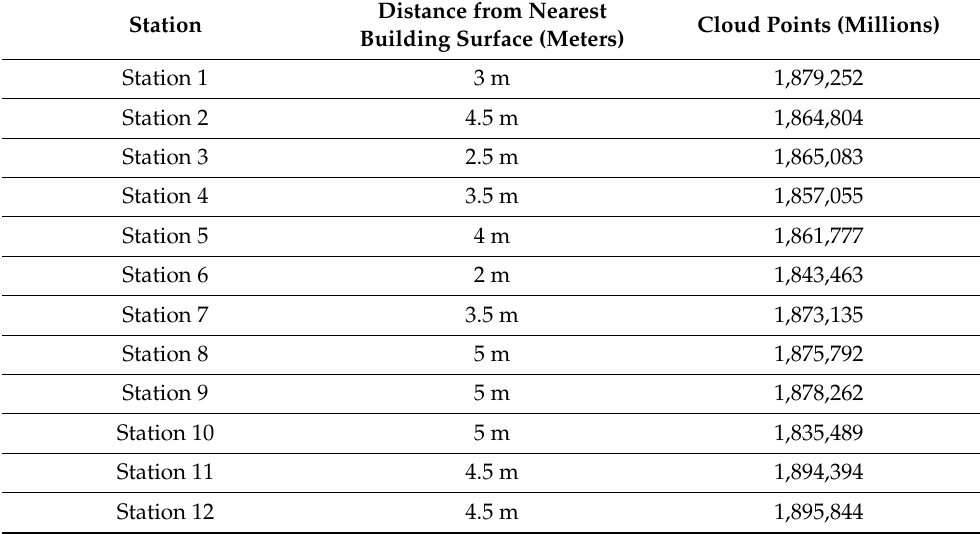
Table 5. Lists Acquired Cloud Points of Internal Scans along with Station Point Distances.